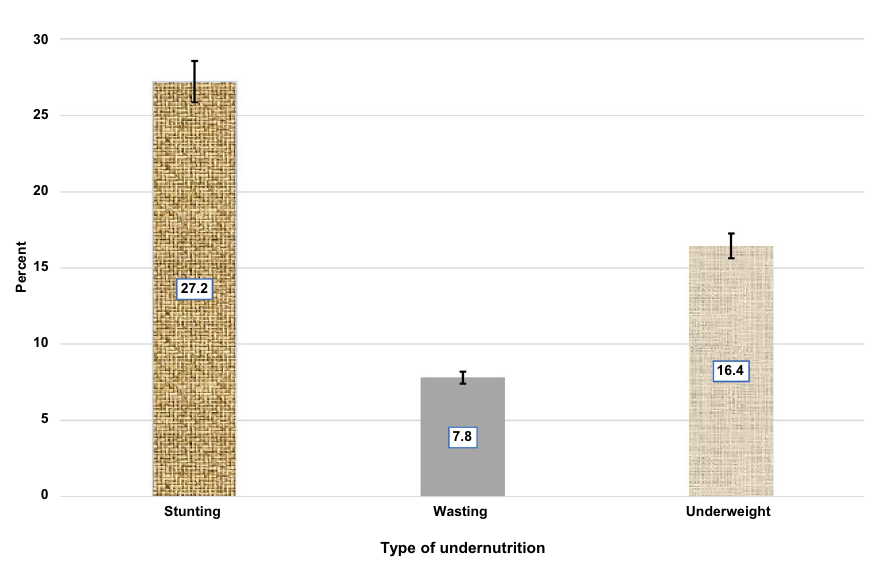
Figure 1. Undernutrition among children 0–23 months of age in Ethiopia,